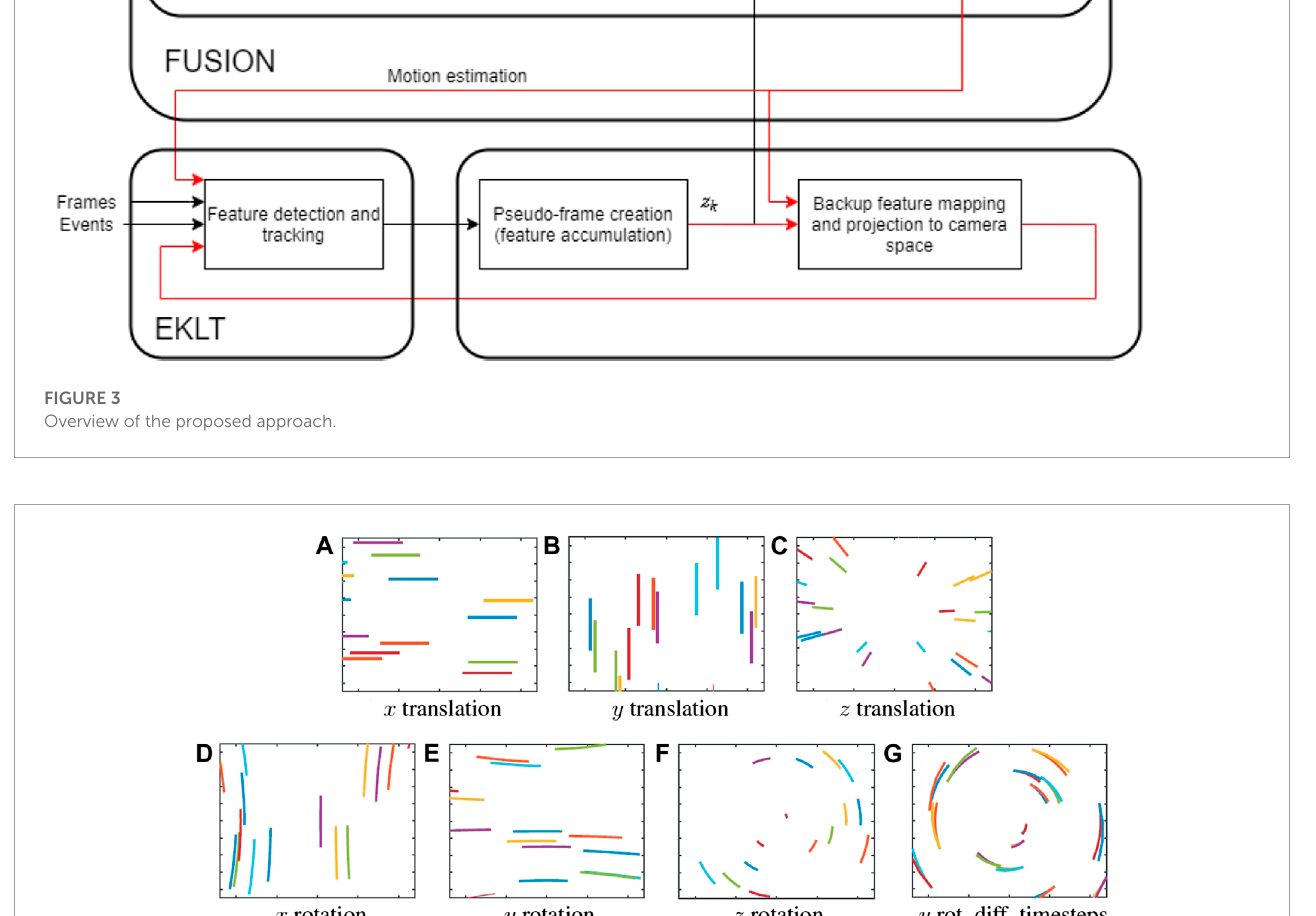
FIGURE 4 Evolution of features’ position over time due to ego-motion. (A–C) show translations in x , y , and z -axis, respectively, and (D–F) show rotations in x , y , and z -axis, respectively. Notice the similarities between (A,E) , and (B,D) . (G) shows drift in expected feature position from bigger